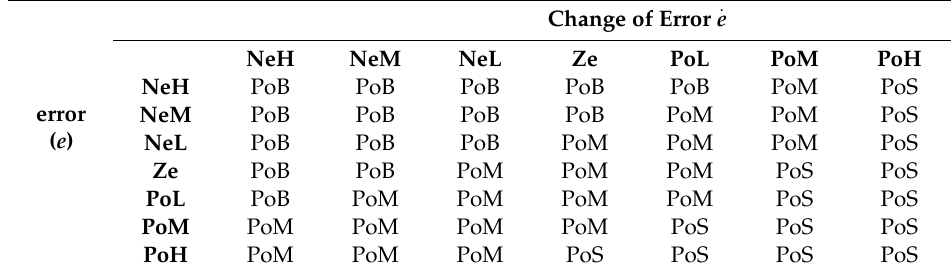
Table 1. The fuzzy rule table for tuning the coe ffi cients in the adaptive neural high order variable structure observer